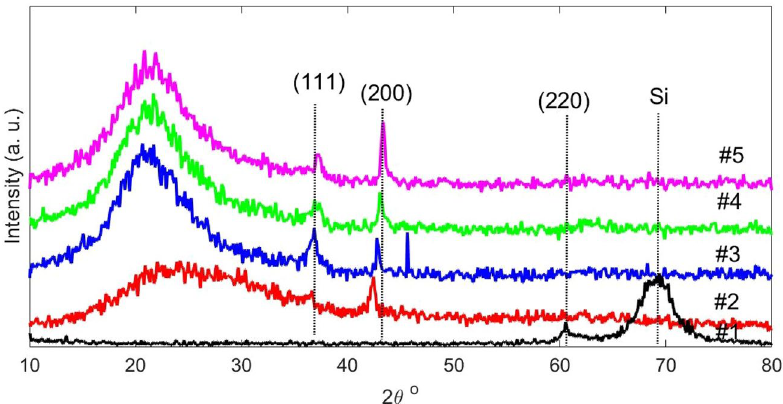
Figure 2. X-ray diffraction spectrum of NiO thin films with different annealing temperatures.